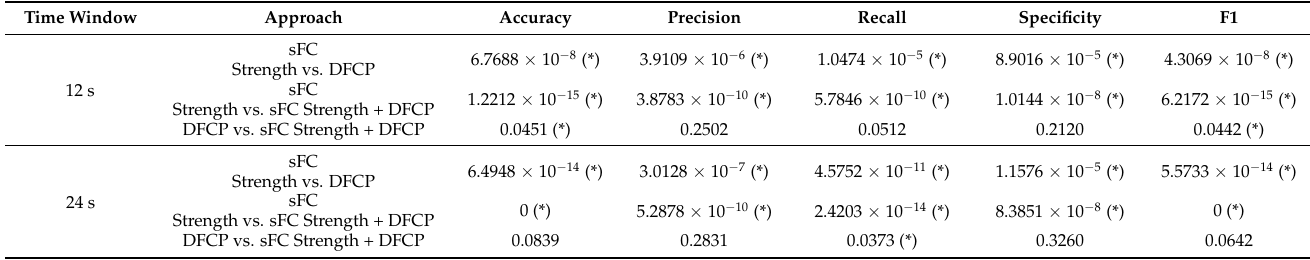
Table 2. The p -value and significance of classification performance matrix along three approaches under different time window lengths, which obtained by two-sample t -test for COBRE dataset. ‘*’ indicates a significant difference between two